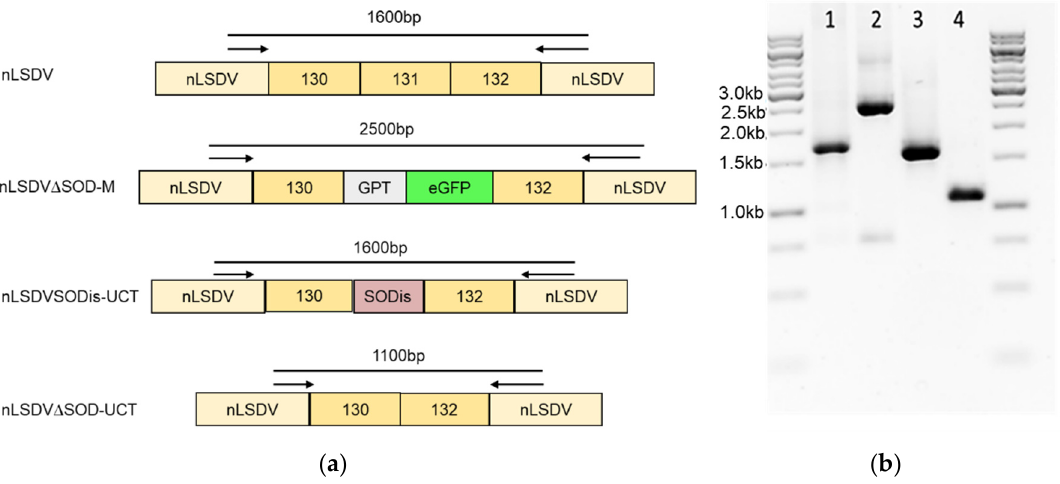
Figure 2. Construction of LSDV SOD knock-out and knock-in recombinants. Using a Neethling vaccine (nLSDV) backbone with the SOD homologue gene, ORF 131, replaced with gpt (GPT) and eGFP (eGFP) as the parent virus (nLSDV ∆ SOD-M), the two recombinants nLSDVSODis-UCT and nLSDV ∆ SOD-UCT were isolated. These two recombinants had no marker genes present in their genomes. ( a ) Diagrammatic representation of the recombinant viruses nLSDVSODis-UCT and nLSDV ∆ SOD-UCT as well as the parent virus nLSDV ∆ SOD-M and nLSDV, showing the sizes of anticipated PCR products using the same set of primers. ( b ) PCR products separated by 1% agarose gel electrophoresis. Lanes: 1 = nLSDVSODis-UCT, 2 = nLSDV ∆ SOD-M, 3 = nLSDV, 4 = nLSDV ∆ SOD-UCT.